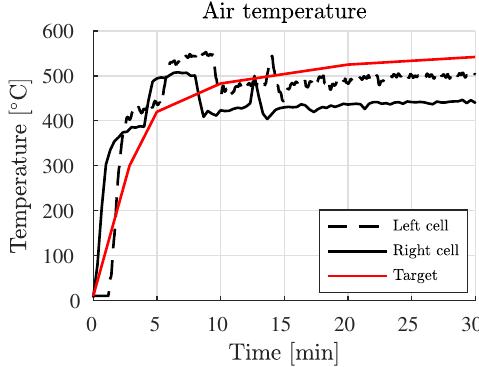
Figure 7. Temperature history of the air inside the tested